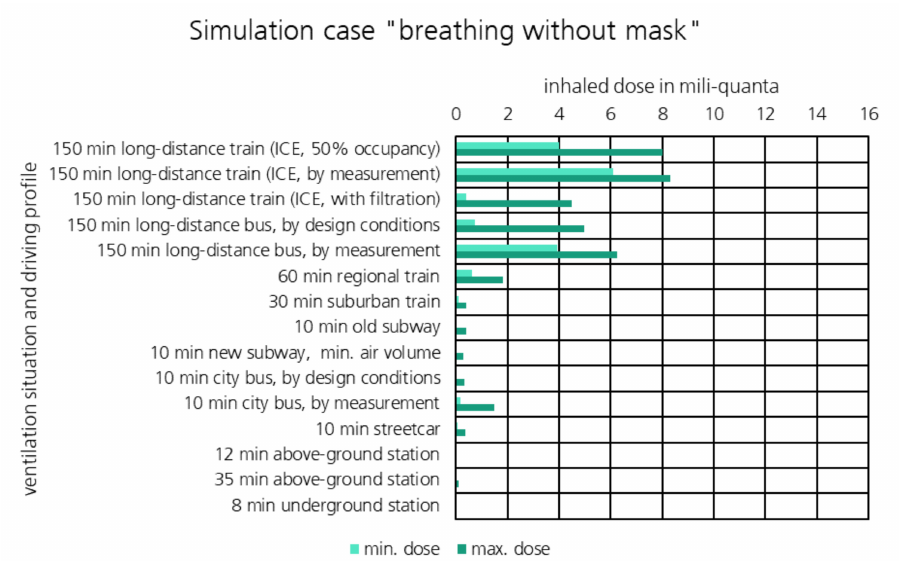
Figure 16. Comparison of typical means of transport considered for the case “Talking with MNP”: min. dose, minimum dose absorbed farther away from the emitter; max. dose, maximum exposure that is absorbed close to the emitter.